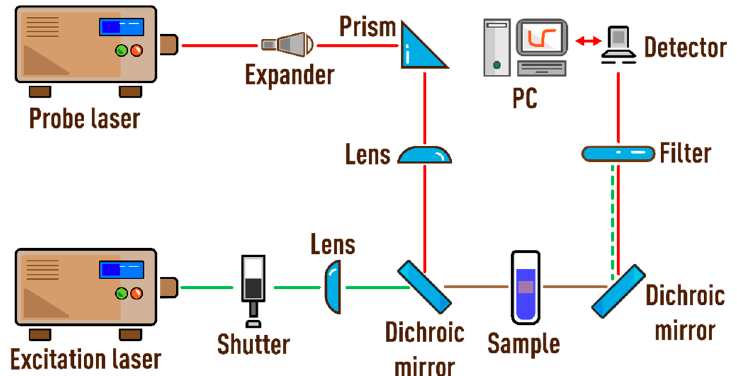
Figure 1. Schematic of the narrow-focused configuration of the thermal-lens spectrometer.